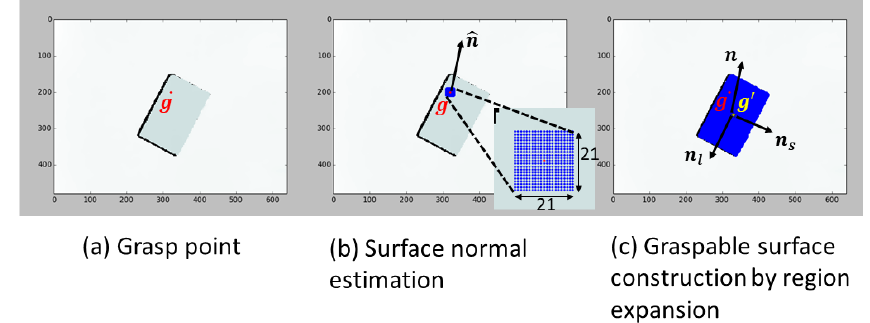
Figure 7. Surface feature descriptor. ( a ) Initially sought grasp point. The red point g is the point g opt predicted by the learning-based grasp planning loop at the robot home position in the first iteration. From the second iteration, this point will be the calculated surface center g (cid:48) in the previous iteration. ( b ) Surface-normal estimation. ˆ n is the estimated surface normal. ( c ) Graspable surface reconstruction by region expansion. The blue surface is the constructed graspable surface. The yellow point g (cid:48) , namely the refined g , is the surface